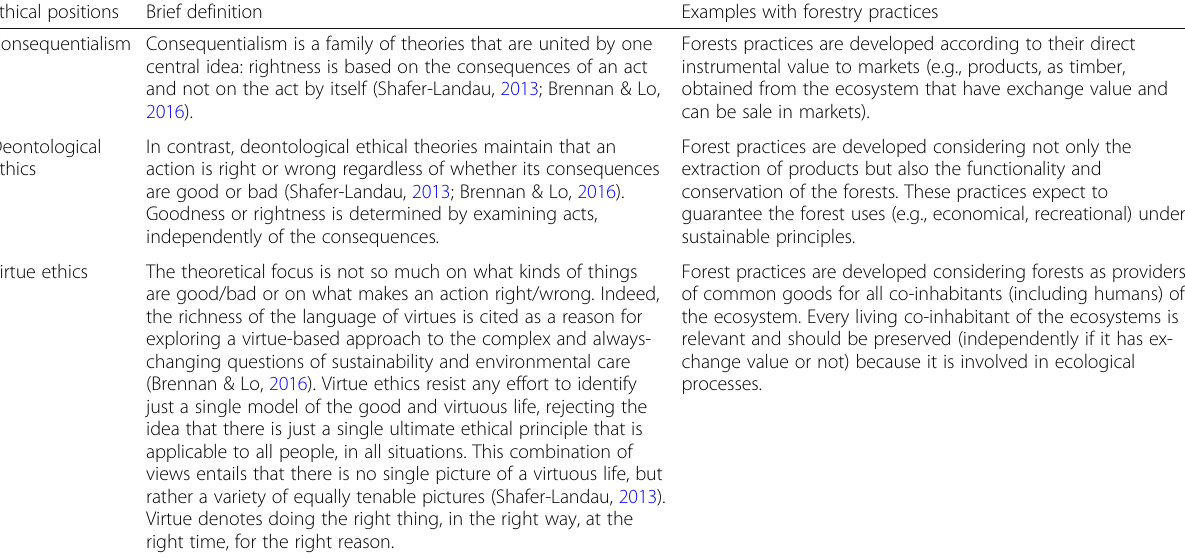
Table 1 Environmental ethical perspectives, definitions, and examples with different forestry practices Ethical